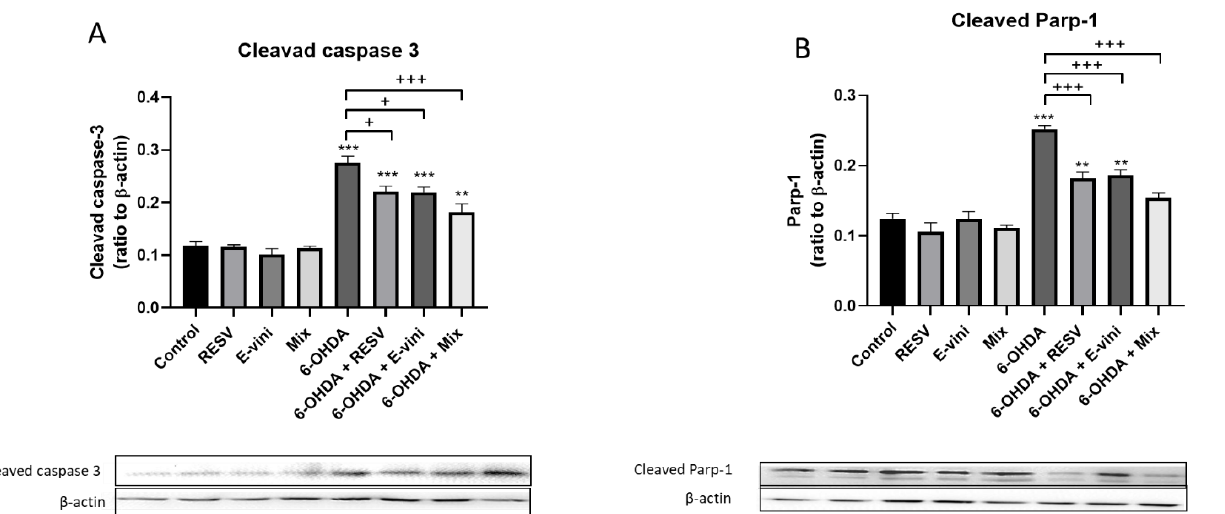
Figure 4. Expression of apoptotic cleaved caspase-3 ( A ) and cleaved Parp-1 ( B ) in PC12 neurons pretreated for three hours with the culture medium (control), resveratrol, viniferin or a mixture of both polyphenols (Mix) at a final concentration of 10 -9 M. Cells were then treated with 6-OHDA at 50 μM for 24 h, as described in the Material and Methods. Top panel: Data are expressed as the ratio of cleaved caspase-3 ( A ) or cleaved Parp-1 ( B ) to β-actin. Bottom panel: representative Western blot bands of cleaved caspase-3, cleaved Parp-1 or β-actin. Optical densities were measured on the same membrane. Data are expressed as means ± SEM of three experiments performed in triplicate. Asterisks (*) indicate statistical differences between the treatments and their respective controls (*** p < 0.001, ** p < 0.01), plus signs (+) denote statistical differences between 6-OHDA and 6-OHDA in the presence of polyphenols (+++ p < 0.001, + p < 0.05).